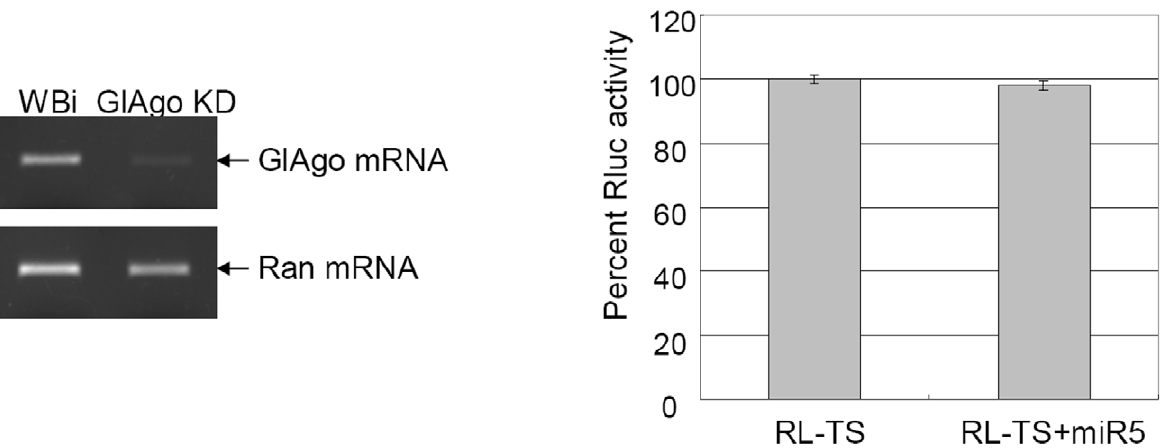
Figure 7. Effects of miR5 on RL-TS expression in GlAgo knockdown cells. Left panel: RT-PCR results showed that GlAgo mRNA was significantly reduced in the GlAgo knockdown Giardia cells (GlAgo KD). The Ran mRNA was monitored as a loading control. Right panel: Introduction of miR5 into the GlAgo KD cells had little effect on RL-TS expression.